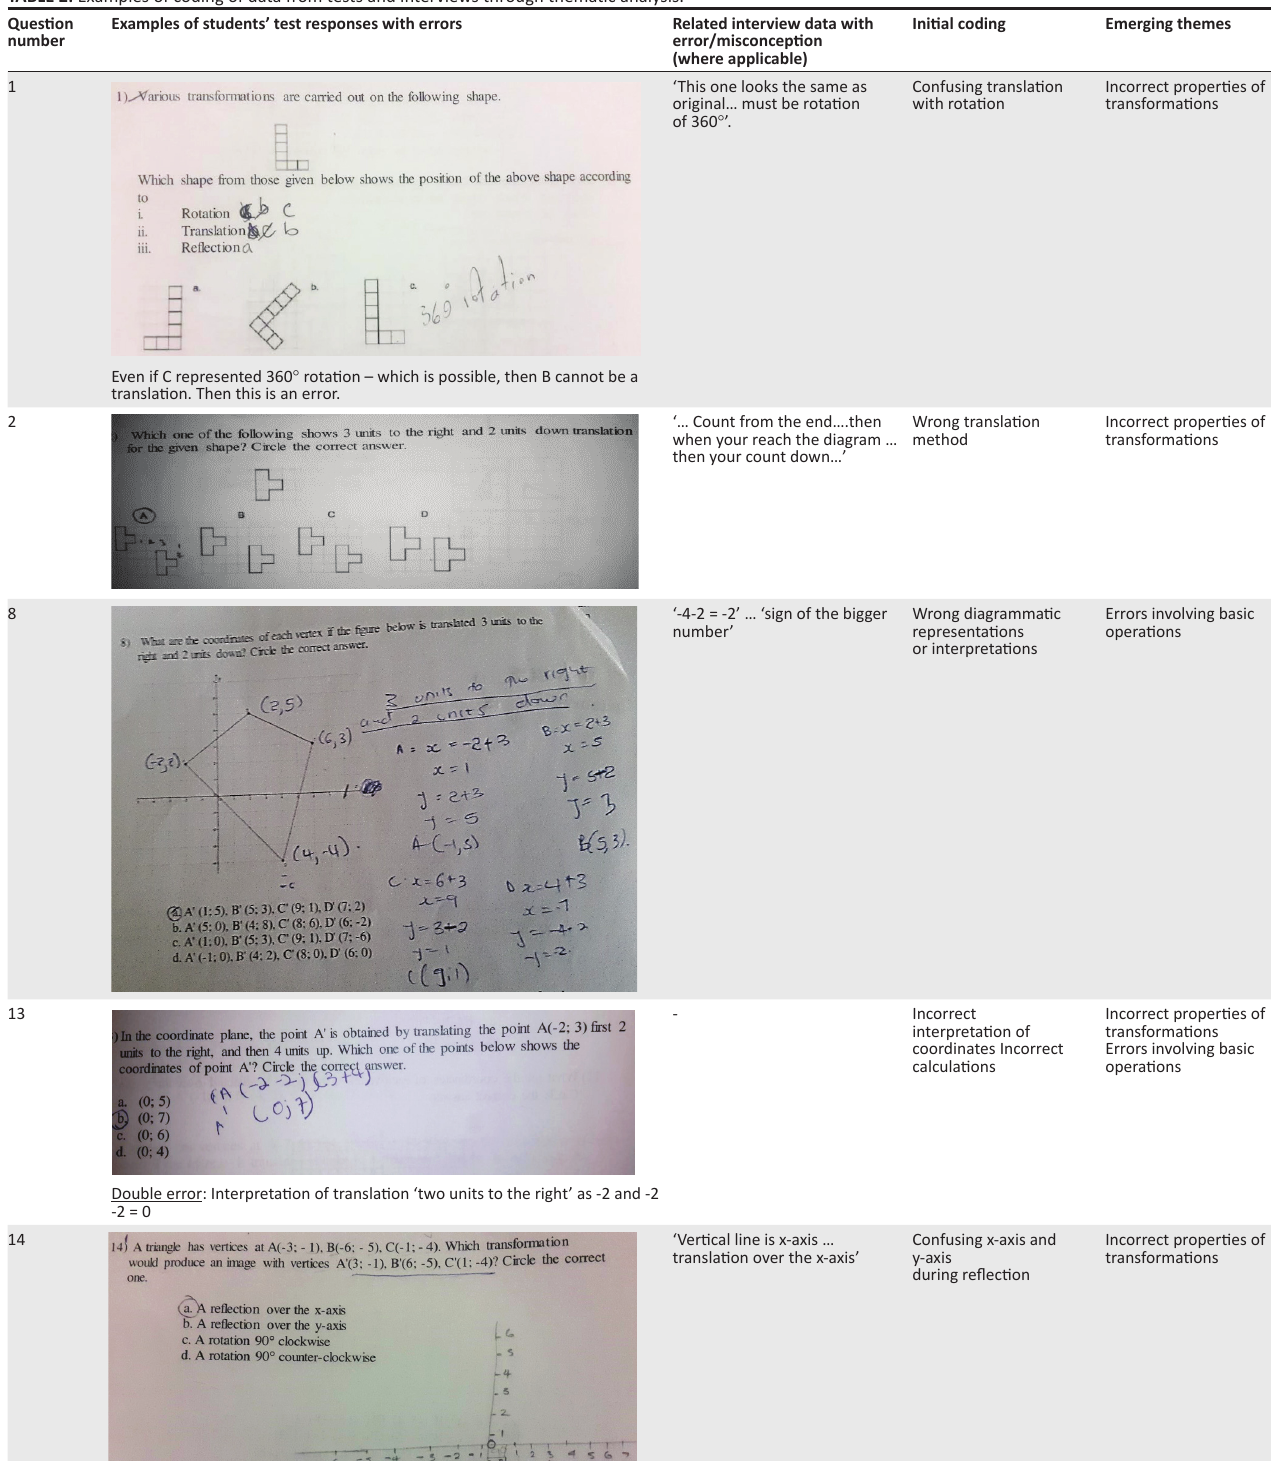
TABLE 2: Examples of coding of data from tests and interviews through thematic